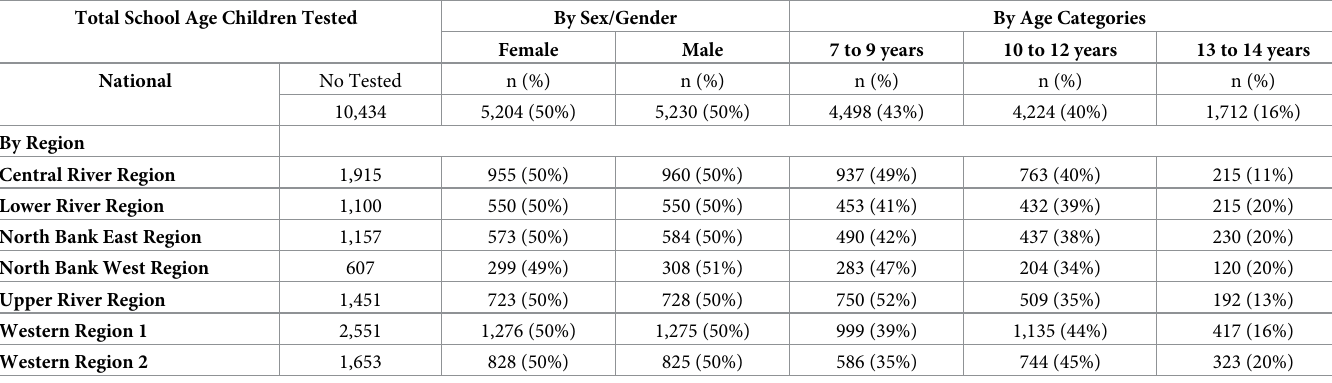
Table 1. Demography of study participants; schistosomiasis and soil-transmitted helminthiases -mapping survey in The Gambia. Total School Age Children Tested By Sex/Gender By Age Categories